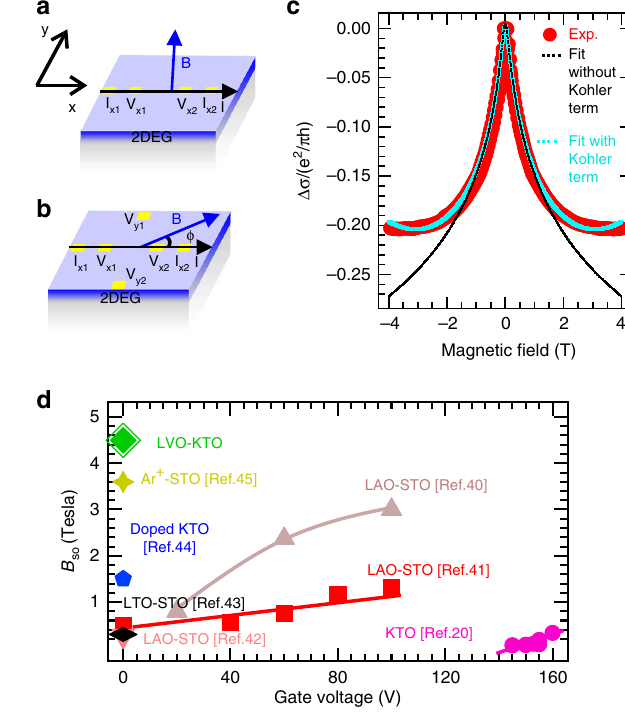
Fig. 3 Spin – orbit coupling strength analysis. (Color online) Schematic of the connection geometry for magnetoresistance ( R xx ) measurements for magnetic fi eld applied ( a ) out-of-plane and b in the plane. c Magnetoconductance plot of 4 ml sample as a function of magnetic fi eld showing weak anti-localization due to high spin – orbit coupling along with the fi tting done without the Kohler term (black line) and the fi t including the Kohler term (cyan line). d Comparative plot of B SO vs. gate voltage for STO and KTO based